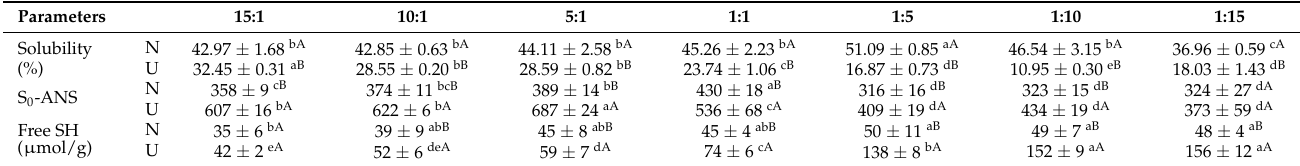
Table 3. Changes in protein solubility, surface hydrophobicity (S 0 -ANS) and free sulfhydryl (SH) group content of emulsions before (non-ultrasound, U) and after ultrasound (U) emulsification